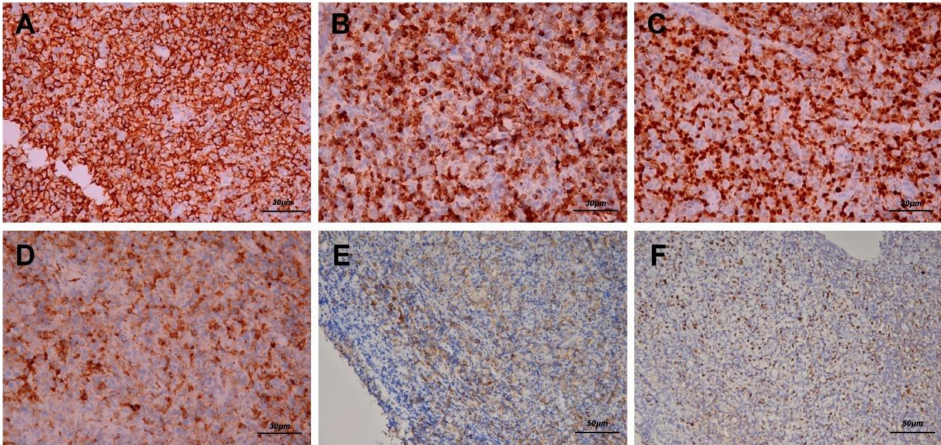
Figure 4. Immunohistochemical staining reveals that the majority of the lymphoid cells were positive for CD20 ( A, 200 × ), CD79A ( B , 200 × ) and multiple myeloma 1 (MUM1) ( C , 200 × ). Some lymphoid cells were positive for CD38 ( D , 200 × ) and positive for CD30 ( E , 200 × ), which indicated that the infiltrates were B cells and plasma cells. In addition, Epstein–Barr encoding region (EBER) in situ hybridization showed positive results ( F , 200 ×